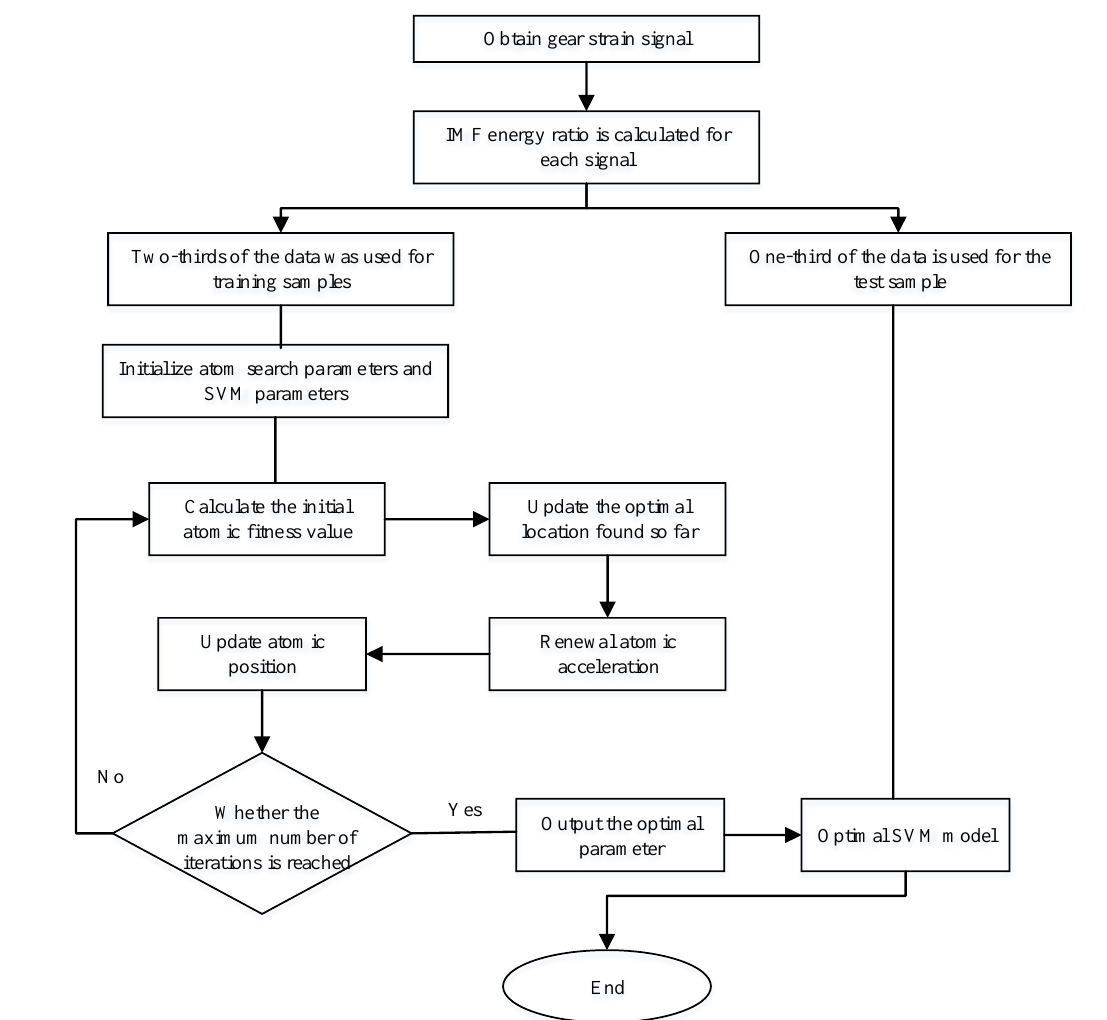
Figure 9. EMD-ASO-SVM algorithm implementation flow chart.